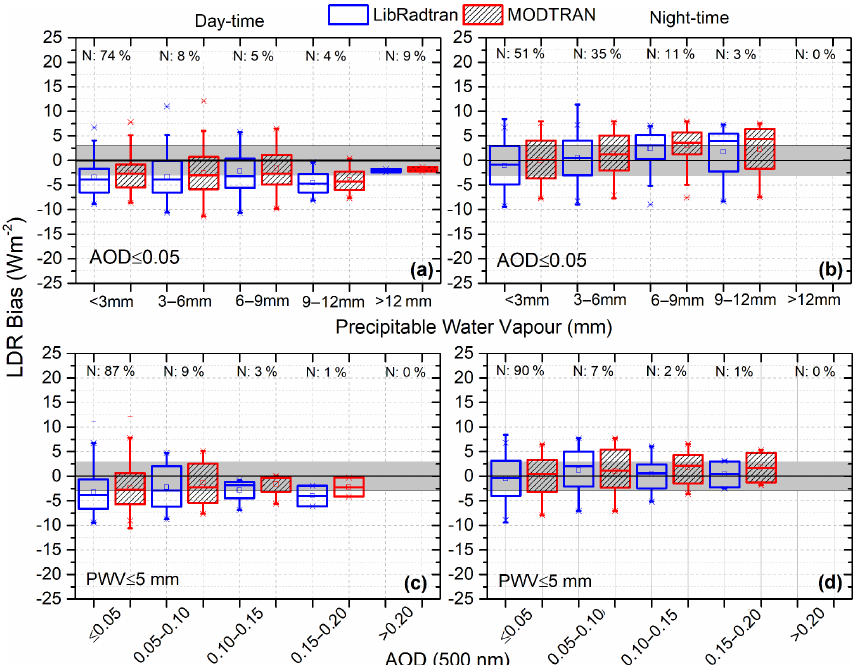
Figure 5. Box plot of mean LDR bias (model–BSRN in Wm − 2 ) vs. PWV (mm) (a) at daytime and (b) at night-time for AOD ≤ 0.05, and vs. AOD at 500nm (c) at daytime and (d) night-time for PWV ≤ 5nm between 2010 and 2016 at IZO. Box plots are defined as in Fig.